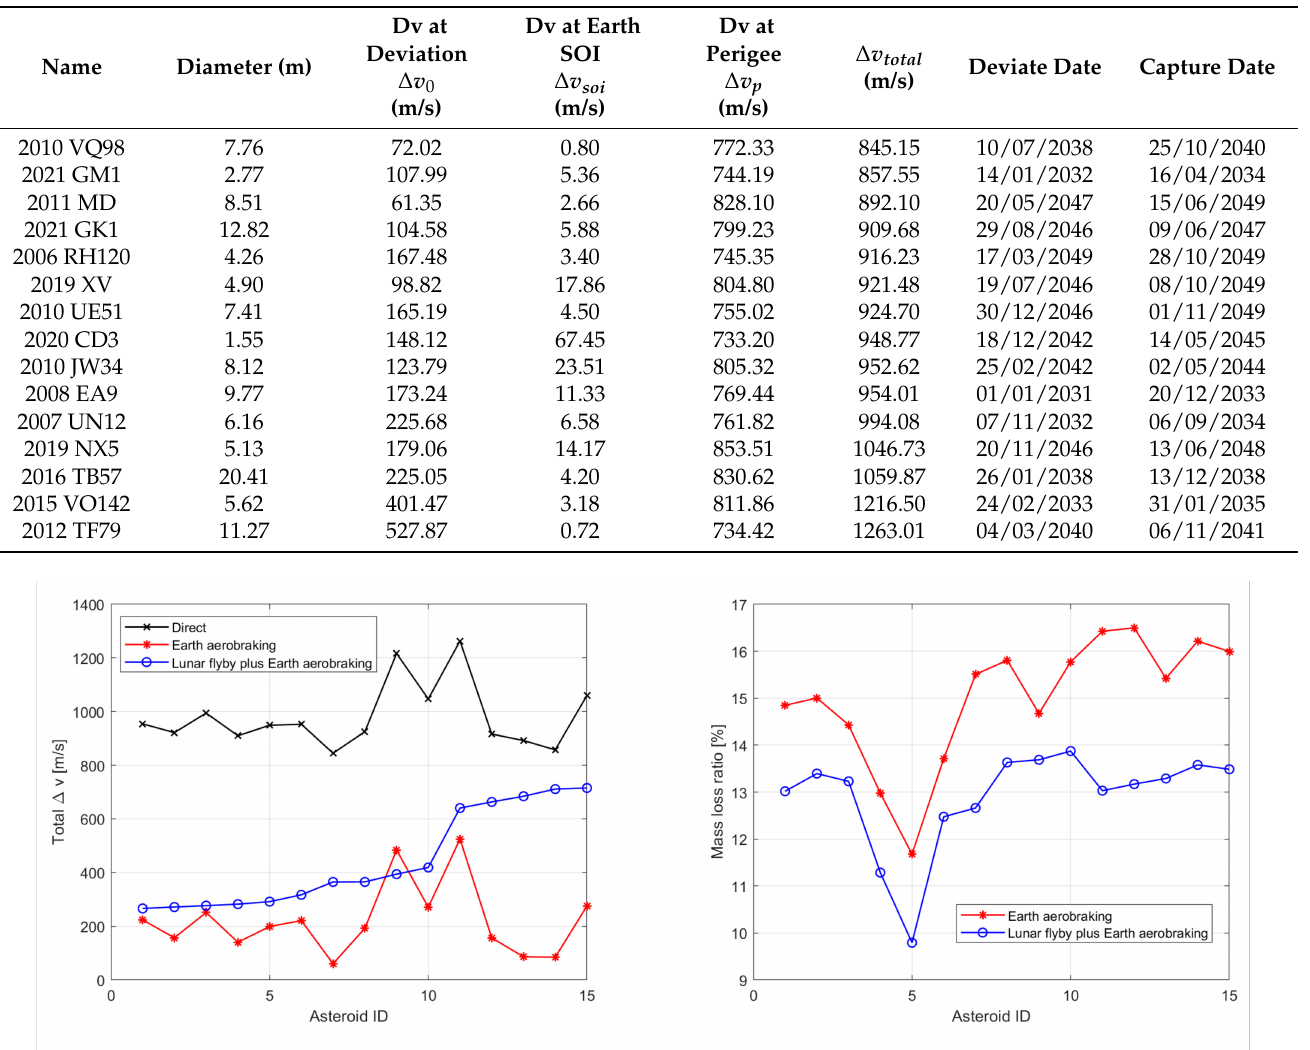
Table 6. Optimization results of direct capture strategy.